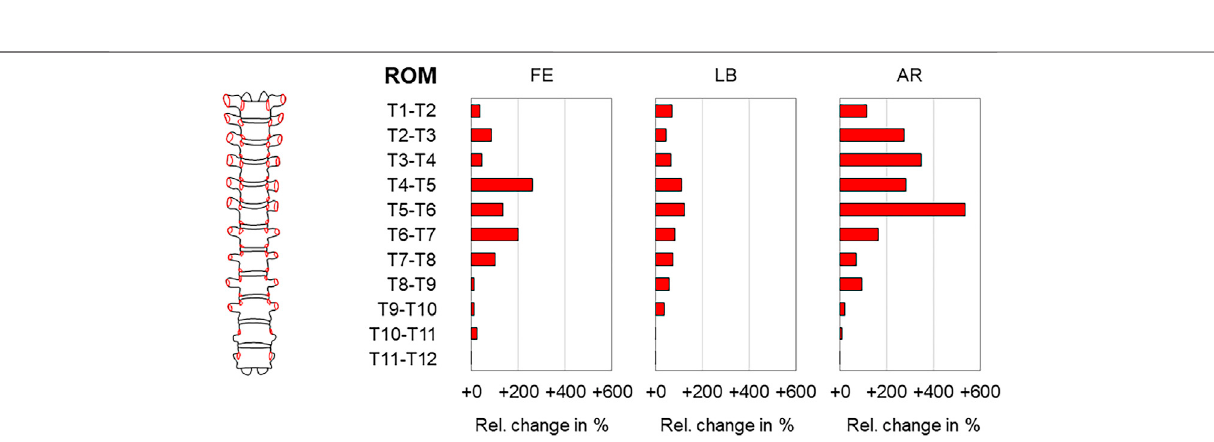
Frontiers in Bioengineering and Biotechnology |